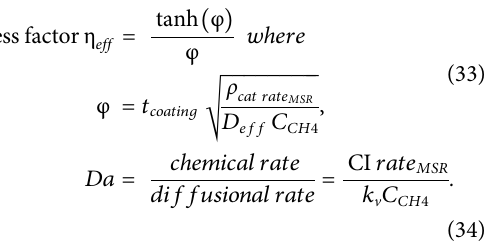
Frontiers in Chemical Engineering |